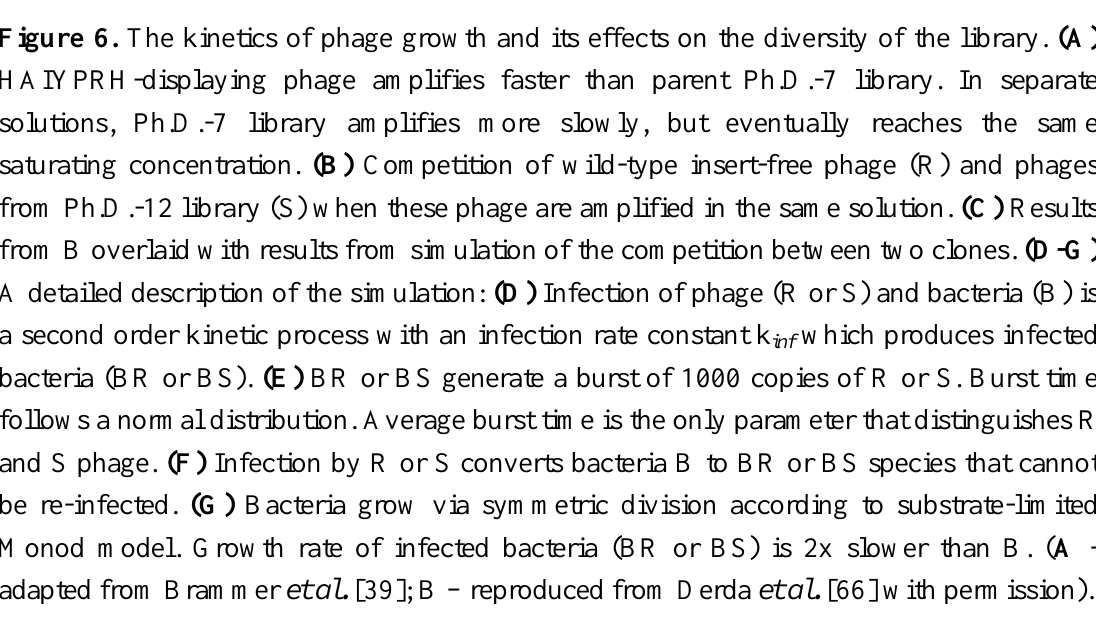
Figure 6. The kinetics of phage growth and its effects on the diversity of the library.